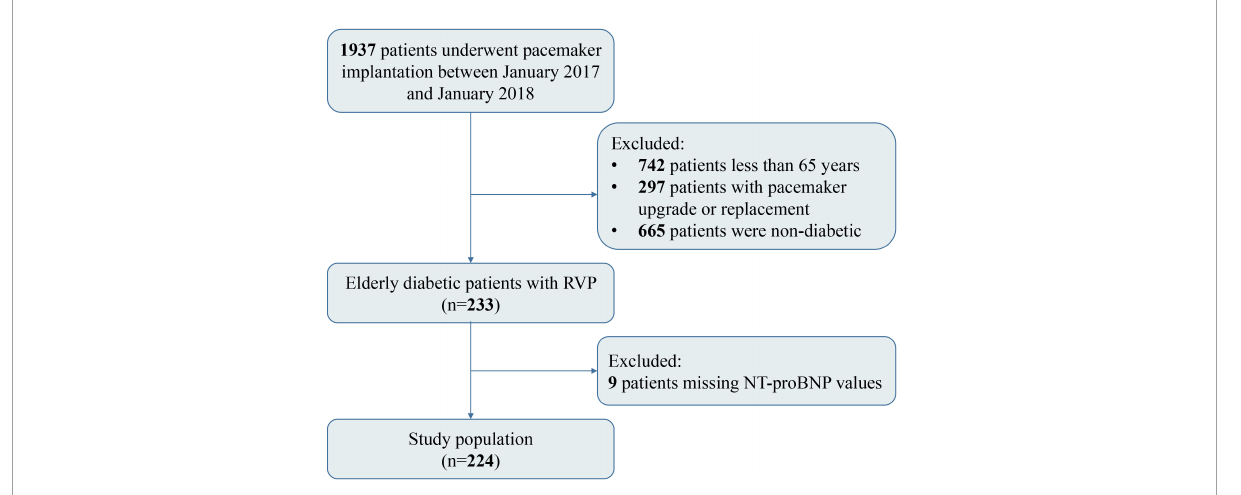
FIGURE1 Flow chart of the study population.